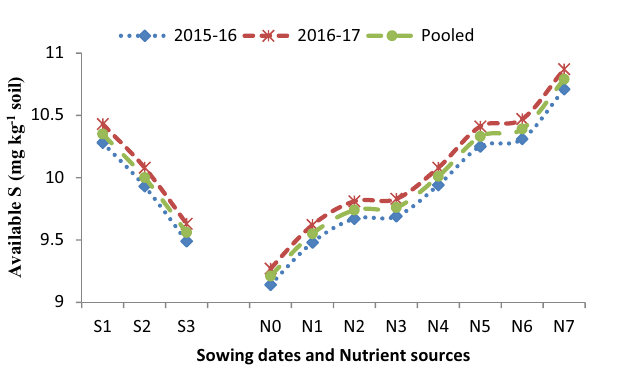
Figure 4. Effect of sowing dates and nutrient sources on available sulfur (S) after the harvest of Indian mustard.